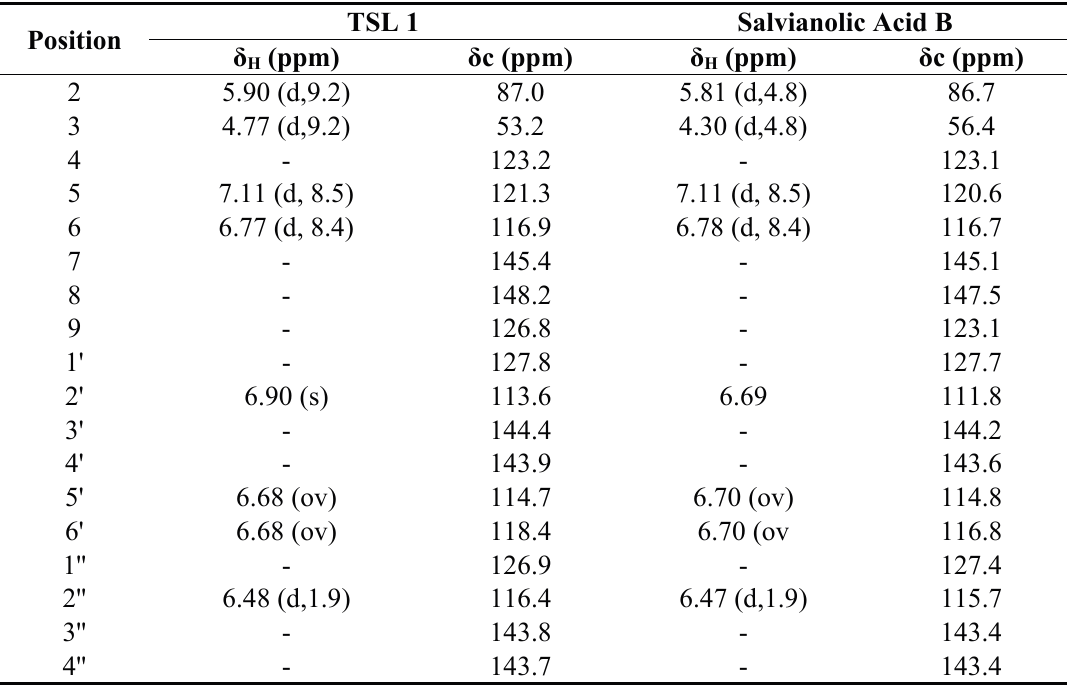
Table 1. NMR data of salvianolic acid Y (TSL 1) and salvianolic acid B (methanol- d 4 , 400 MHz/100